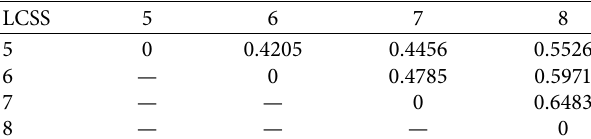
Table 4: Similarity LCSS of the ngsim driver lane change trajectory.